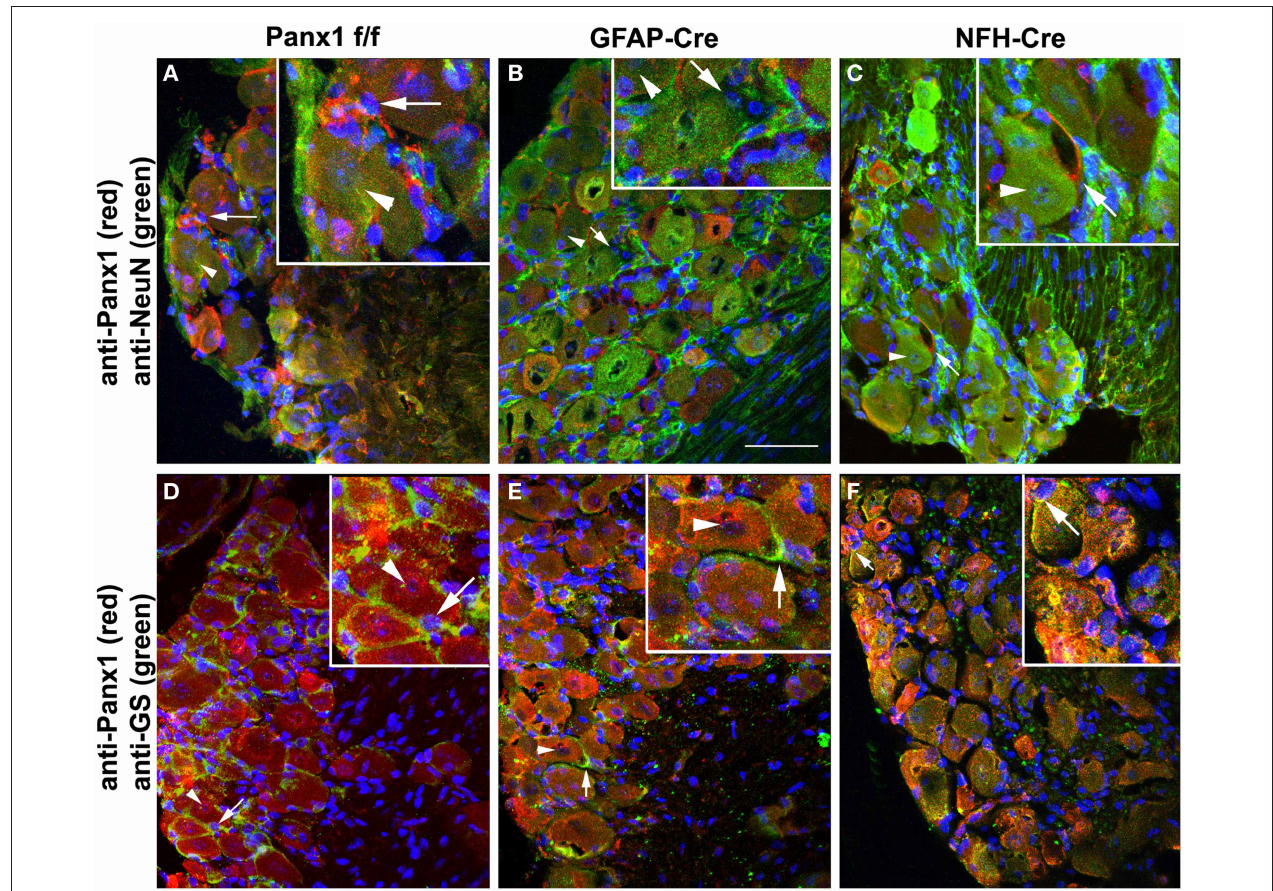
FIGURE 6 | Conditional deletion of Panx1. Confocal images of trigeminal ganglia showing expression of Panx1 in satellite glial cells and neurons in Panx1 f / f (A,D) , GFAP-Cre:Panx1 f / f (B,E) and NFH-Cre:Panx1 f / f (C,F) mice. The cell-specific markers NeuN and glutamine synthase (GS) were used to identify neurons (arrowheads) and glial cells (arrows), respectively. Panx1 immunostaining is evident in both neurons and glial cells of Panx1 f / f mouse ganglion (A,D) . In GFAP-Cre:Panx1 f / f mice Panx1 immunoreactivity (red) is observed in neurons and not in glial cells (B,E) . Conversely, in